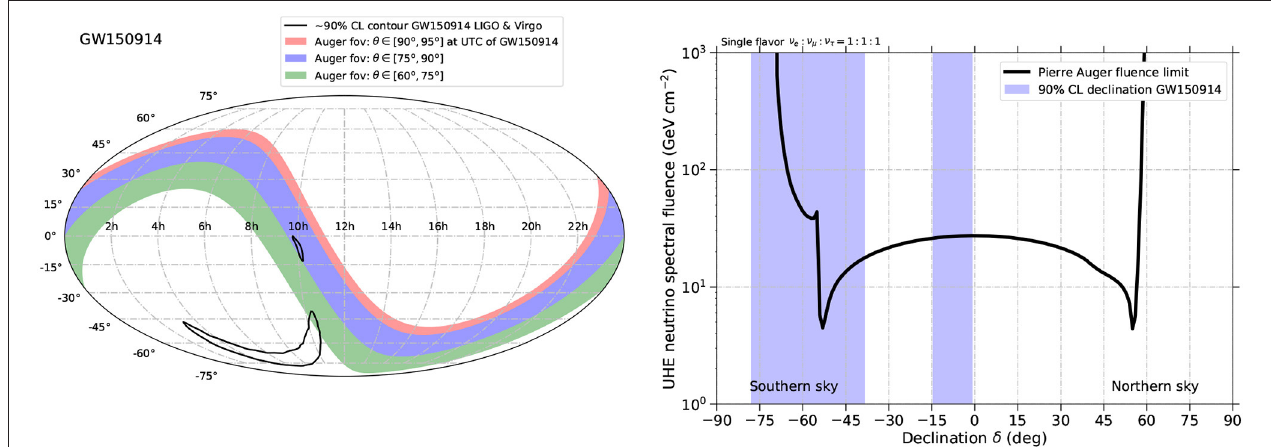
FIGURE 2 | (Left) Field of view of the Observatory exemplified at the instant of detection of the black hole coalescence event GW150914 by Advanced LIGO ( LIGO-Collaboration, 2018). The band limits from top to bottom correspond to lines of zenith angles 95 ◦ , 90 ◦ , 75 ◦ , and 60 ◦ , used to separate the neutrino search into ES, DGH, and DGL channels. The black contours give the 90 % C.L. region of the reconstructed position of the BH merger as obtained by LIGO observations. (Right) Upper limit at 90 % C.L. to the neutrino spectral fluence in the 100 PeV to 25 EeV range as a function of declination (see text), for the detection of black hole merger GW150914. The blue band is the 90 % C.L. of the reconstructed source declination, illustrating the limited precision level achieved using just detections at two LIGO sites.